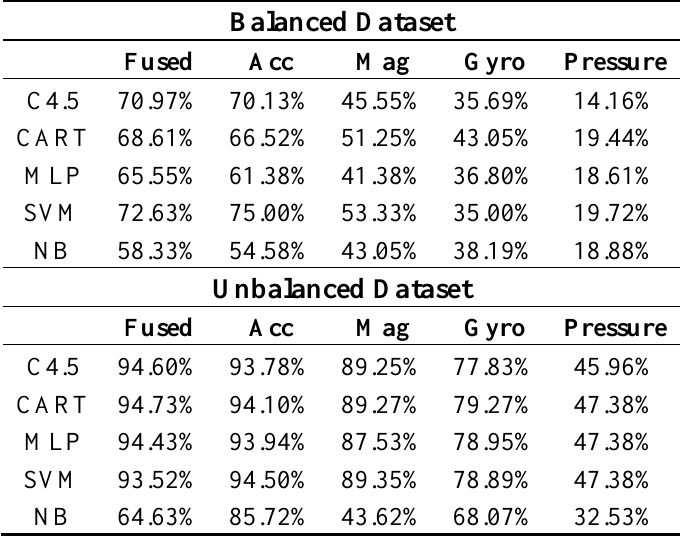
Table 4. Smartphone-based activity recognition.